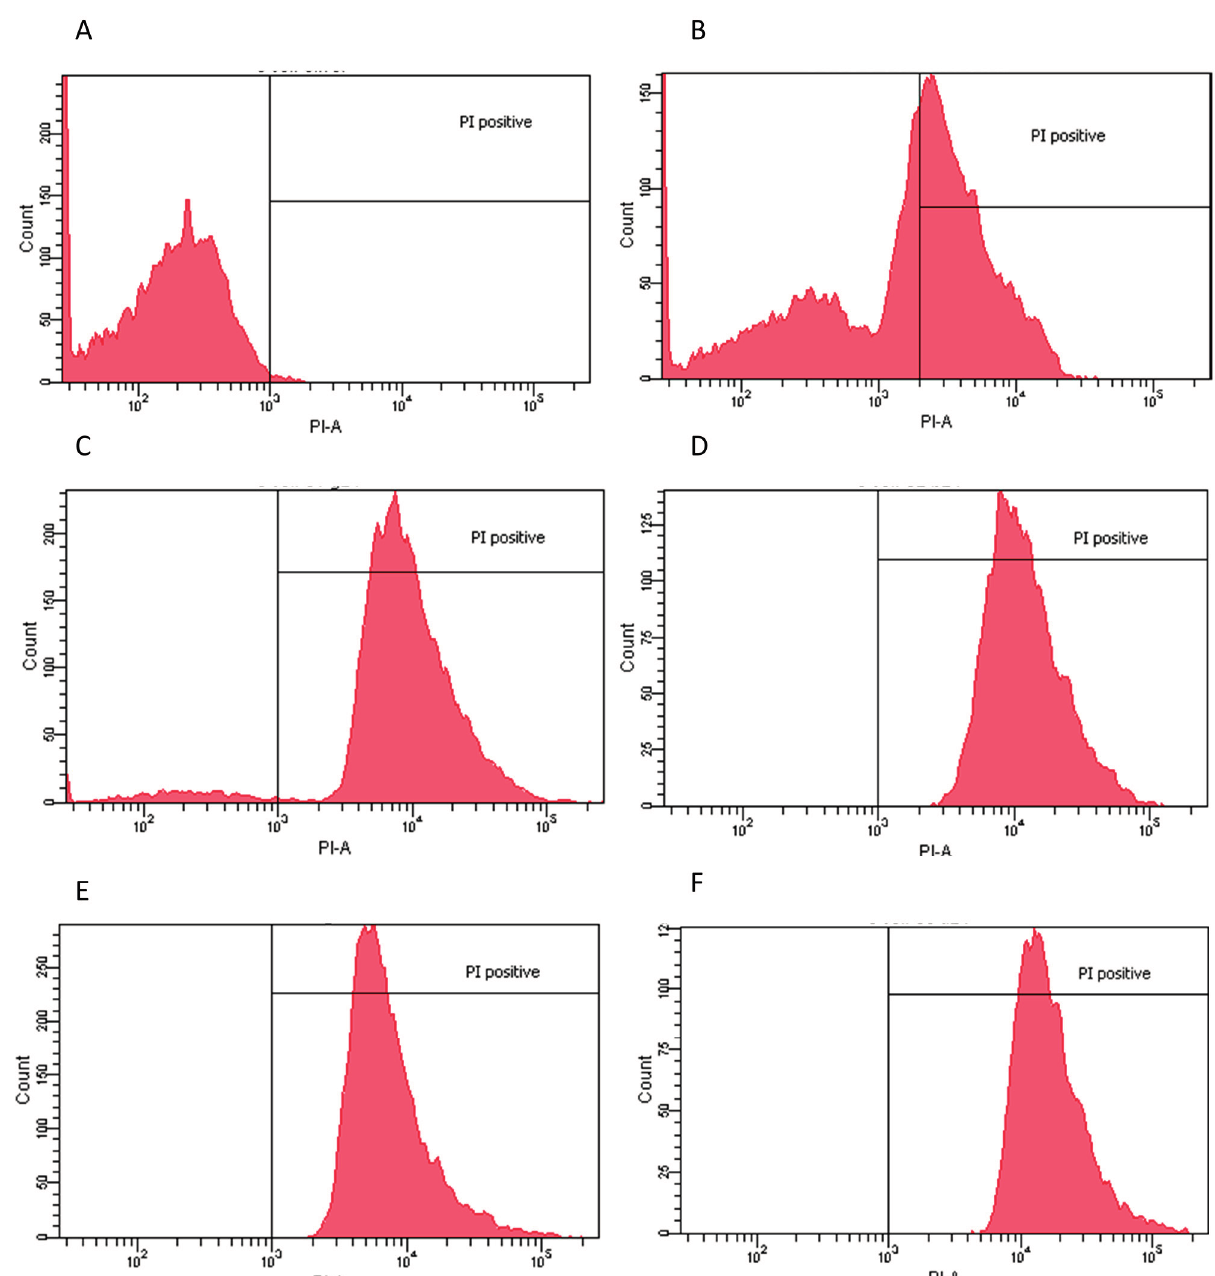
Figure 2. Flow cytometry histograms derived from scatter plots showing fluorescence of live (<103) or dead (>103) E. coli stained with propidium iodine (PI) post 24 h incubation with controls or extracts. X-axis corresponds to the PI positive marked microorganisms and Y-axis to the total cell count. ( A ) E. coli sample PI negative control, 96.7% viability; ( B ) E. coli incubated for 30 min with 70% ethanol PI positive control, 48% viability; ( C ) water dry leaf non-boiled extract 4 μ g/mL, 5.7% viability; ( D ) water non-dried leaves non-boiled, 1.5 μ g/mL 0.1% viability; ( E ) ethanol 4 μ g/mL, 0.1% viability; and ( F ) ethyl Acetate 1 μ g/mL, 0.3%